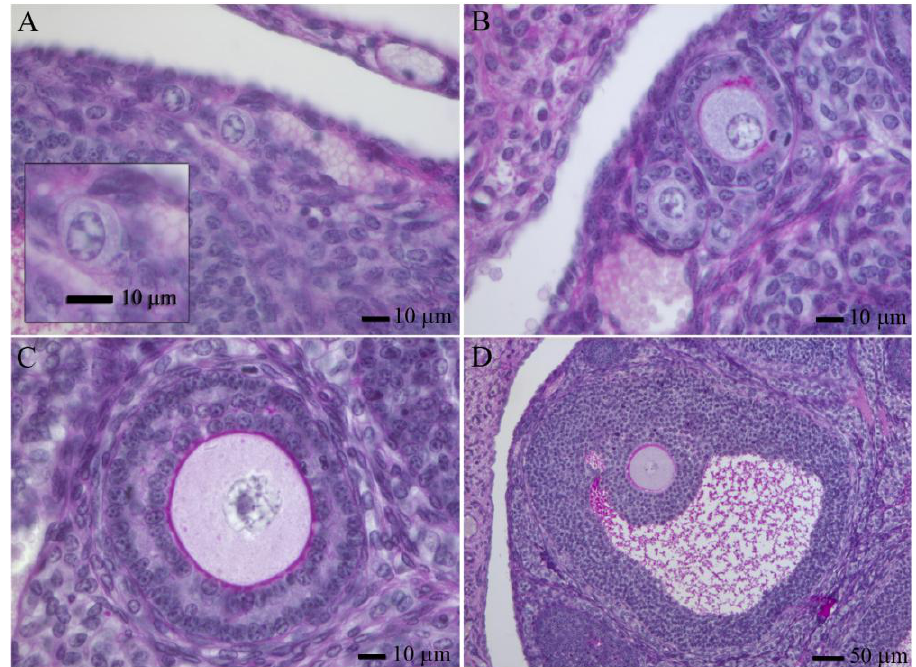
Figure 1. Follicle development in the adult mouse ovary. Primordial ( A ), primary ( B ), pre-antral ( C ) and antral ( D ) follicles stained with PAS-hematoxilin